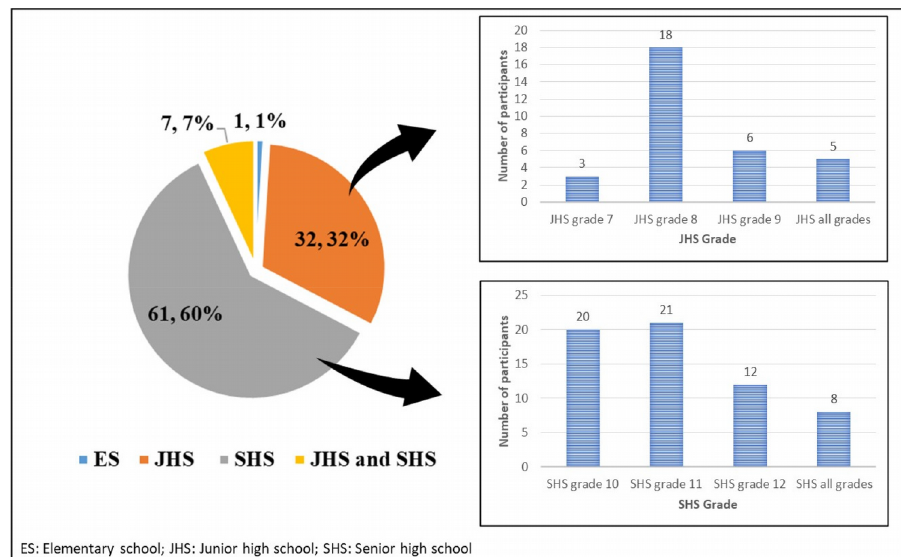
Figure 4. Suitability to the grades